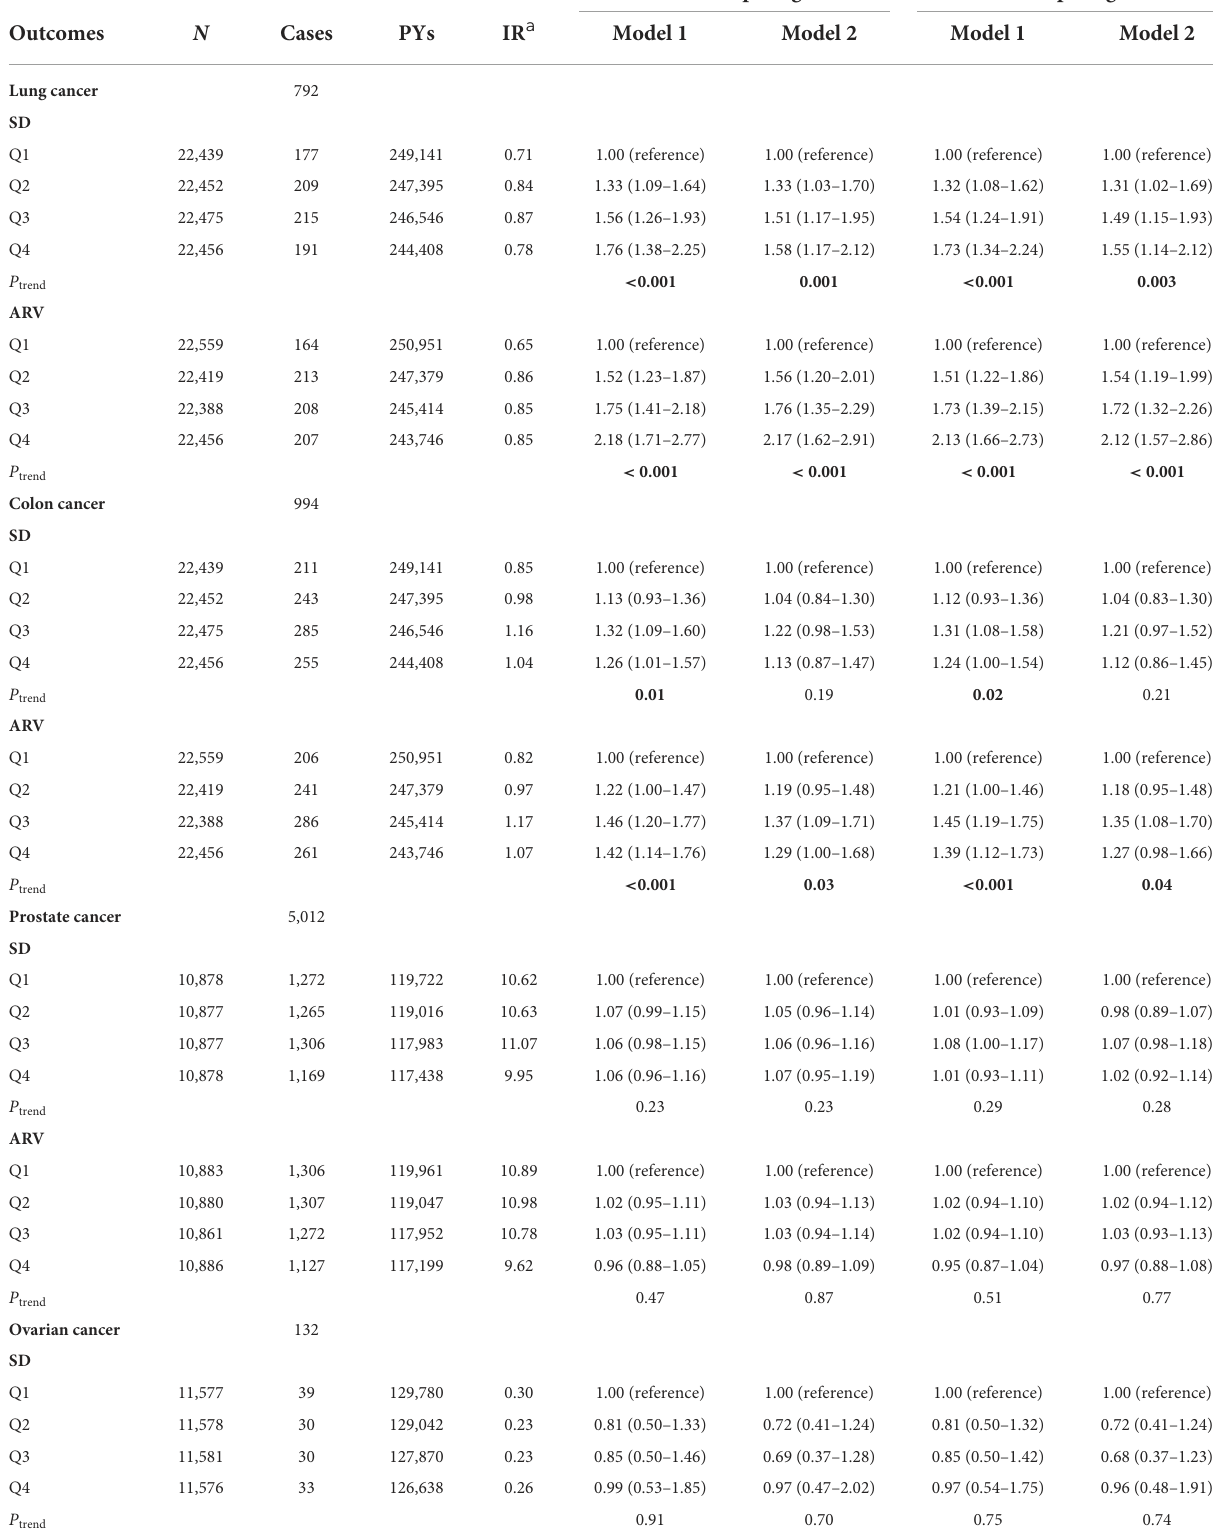
TABLE 2 SD and ARV for BMI variability in relation to the risks of prostate, lung, colon, and ovarian cancers. Without competing risks With competing